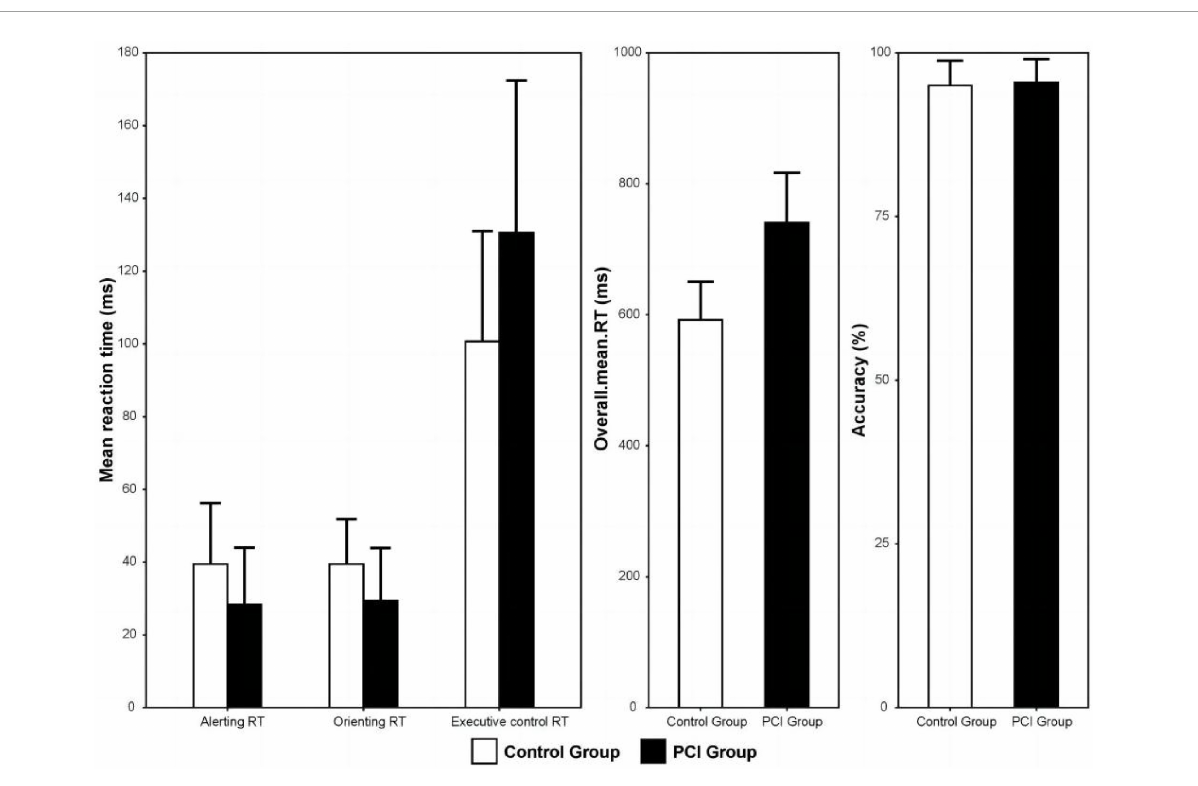
FIGURE4 Mean response time of the PCI and control groups for the three kinds of attention network. Error bars represent standard deviation. PCI, posterior circulation ischemia; RT, response